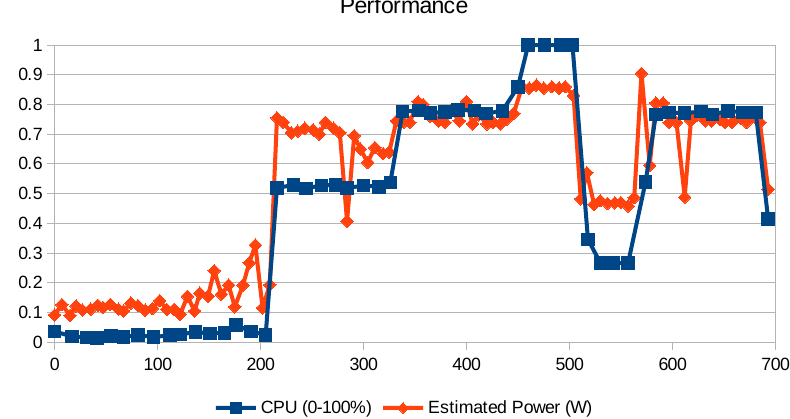
Figure 9. Correlation of energy consumption and CPU workload using performance governor.